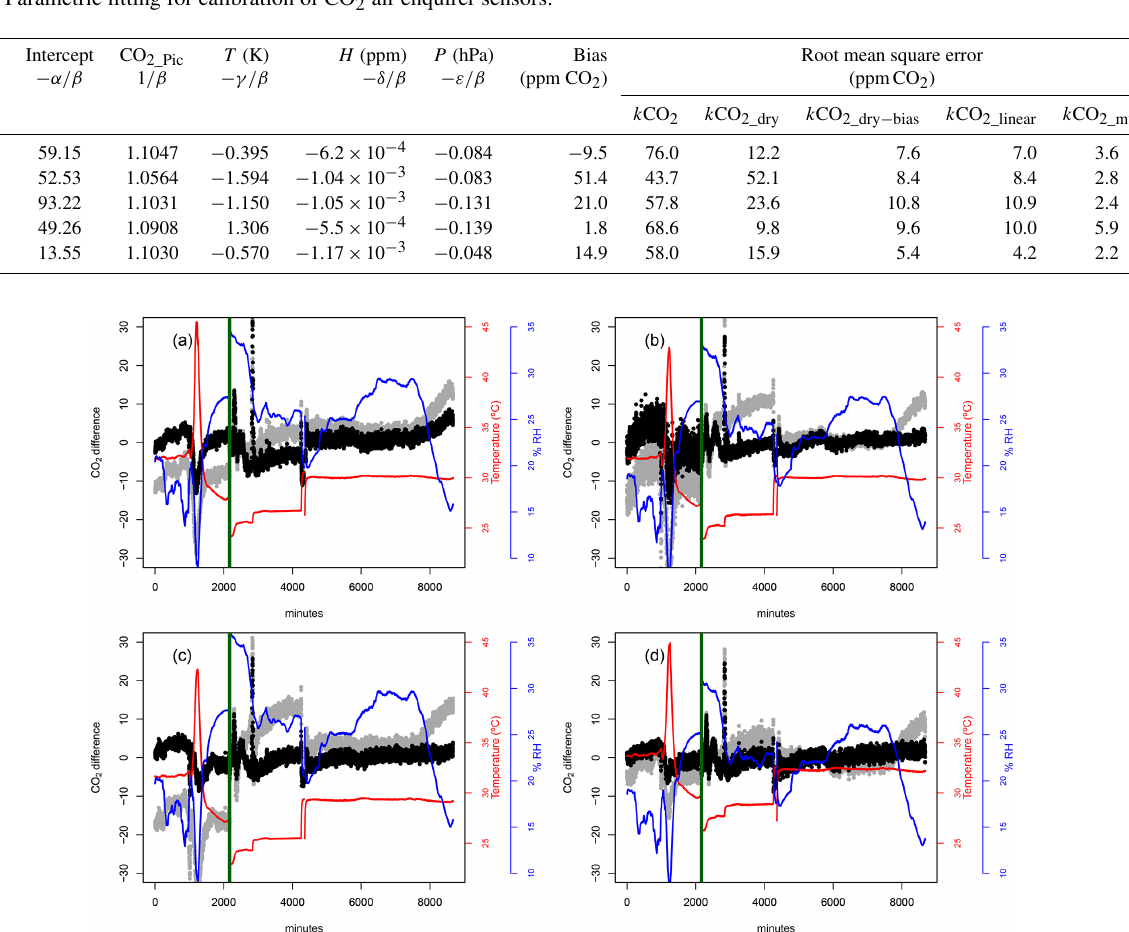
Figure 4. Time series of differences between CRDS CO 2 values and CO 2 AE kits values after simple calibration (grey) and after multipara- metric fitting (black) for AE kit no. 1 (a) , kit no. 2 (b) , kit no. 3 (c) , and kit no. 5 (d) . Temperature values (red) and RH values (blue) are also plotted. Values before the vertical green line correspond to the calibration at IC3 and after the vertical green line to the calibration at